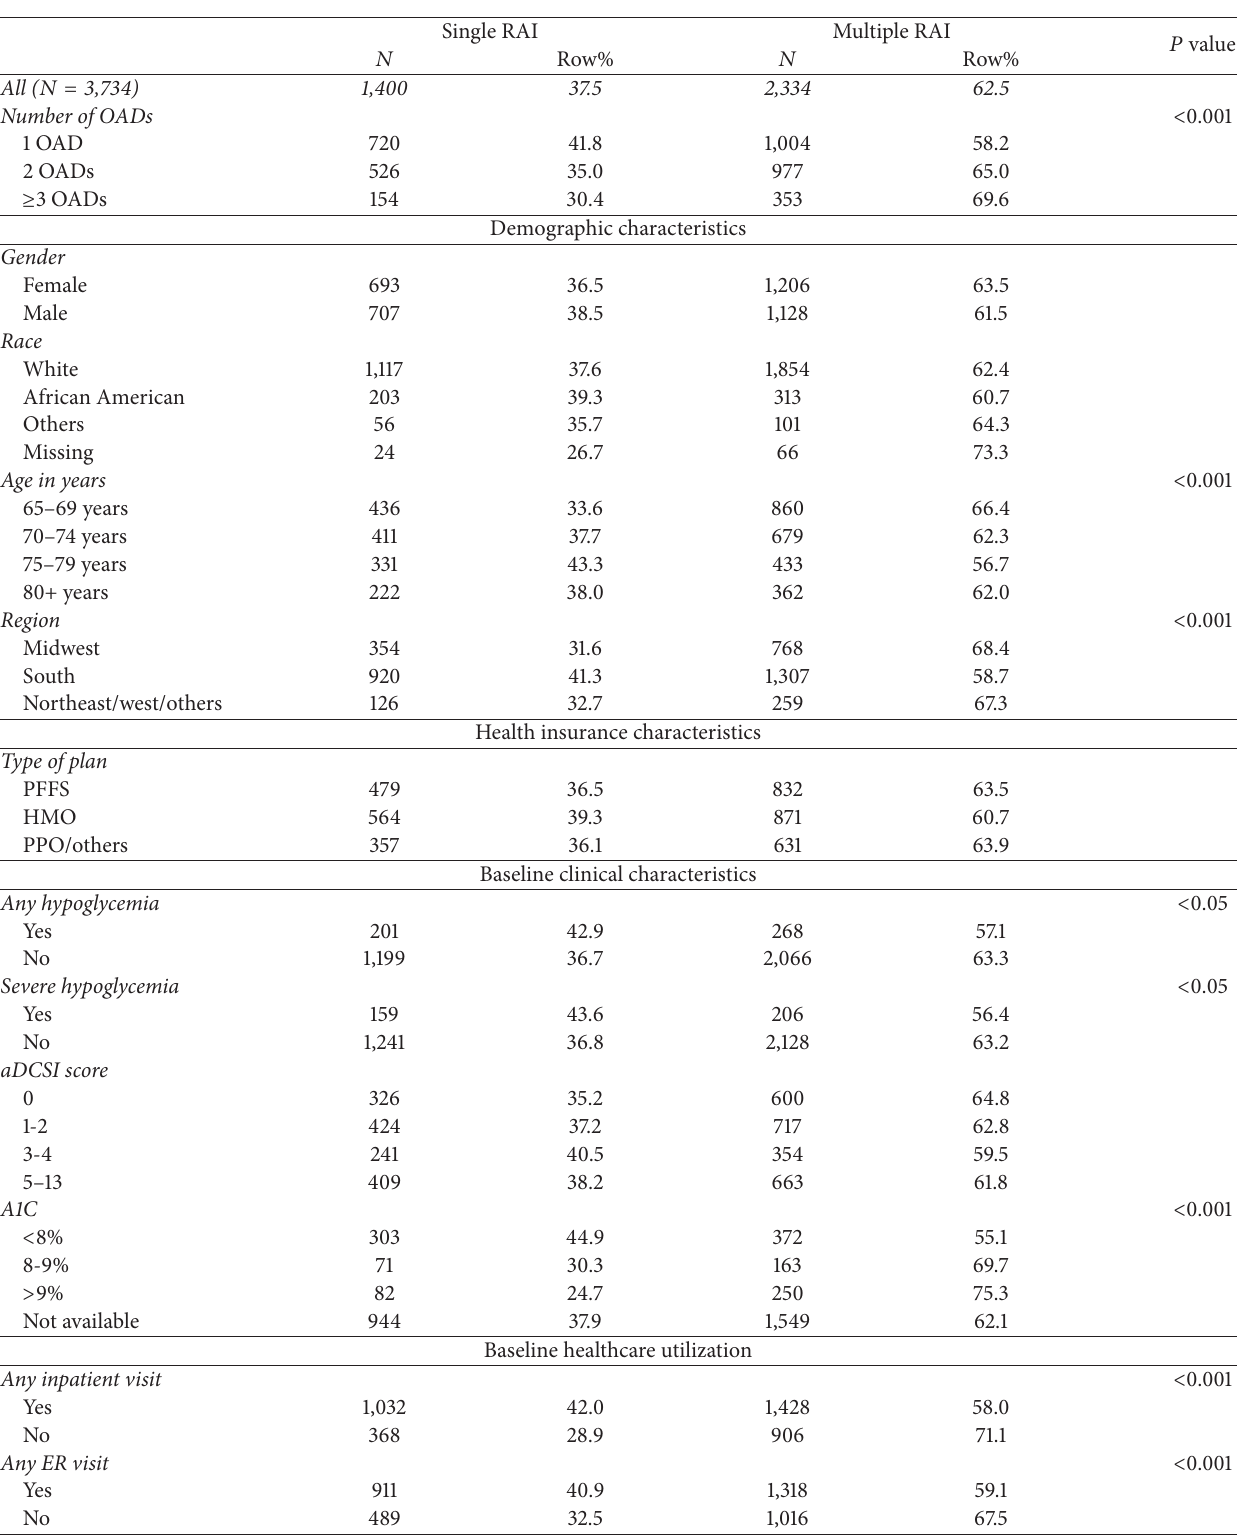
Table 2: Description of elderly ( ≥ 65 years) Medicare beneficiaries with type 2 diabetes mellitus who newly added rapid acting insulin to their oral antidiabetic drug regimen. Single versus multiple rapid acting insulin prescription during one-year follow-up. Humana Medicare Advantage Prescription Drug Plan database